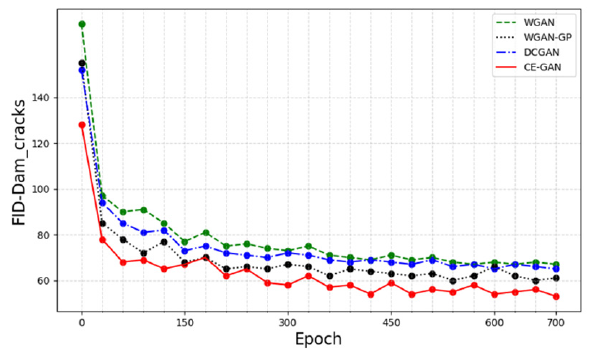
Figure 13. The graph of FID value.